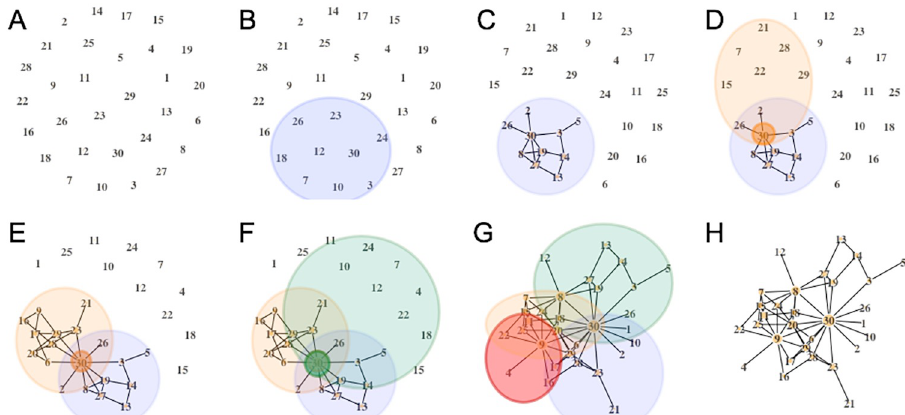
Fig 3. (A) The initial graph with n nodes, (B) random sample of nodes for the first module, (C) random network structure for the module, (D) sample a link node and populate the second module, (E) random structure for the second module, (F) continue creating modules until every node is sampled at least once, (G) the final network is composed of overlapping modules, (H) the undirected graph is the union over all modules.